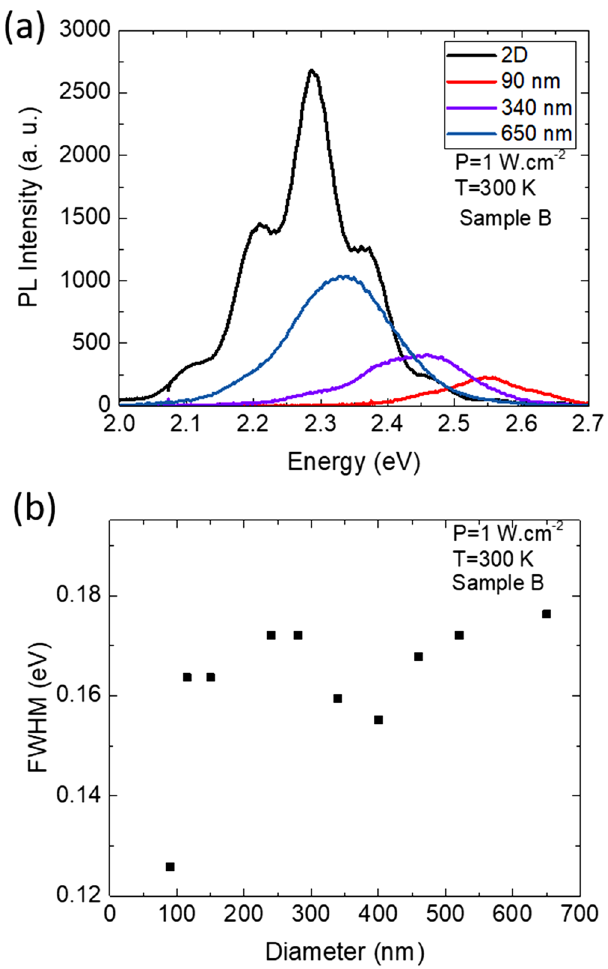
Figure 3. ( a ) RT-PL spectra of sample B as a function of the diameter of the NRds at P = 1 W cm −2 . ( b ) FWHM of spectra in ( a ) as a function of the NRds